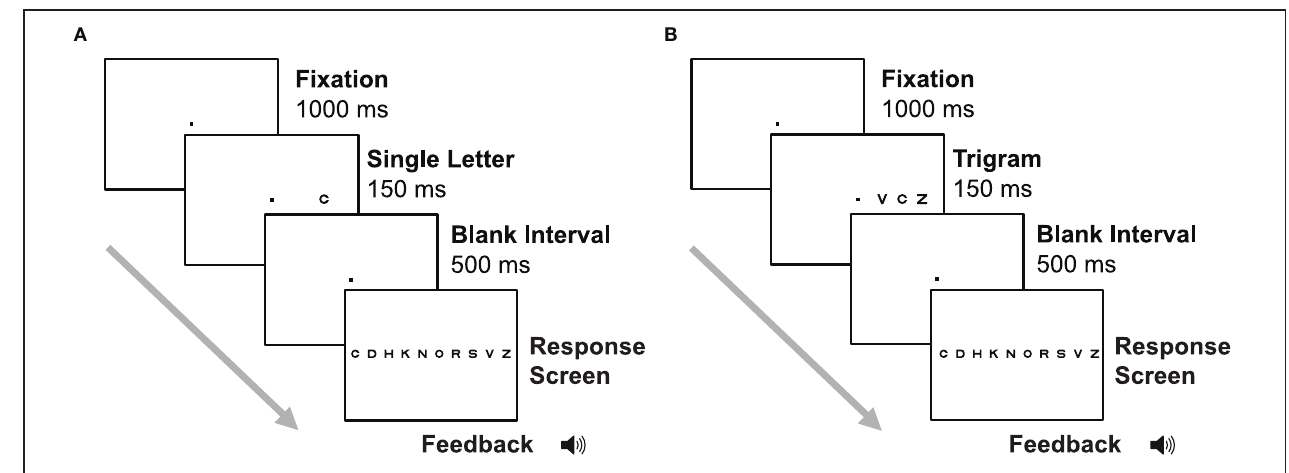
FIGURE 2 | Trial sequence for the letter acuity (A) and crowding (B) tasks in Experiment 2. In the letter acuity task, subjects were presented with a single letter from a set of 10, in either the left or the right visual field.